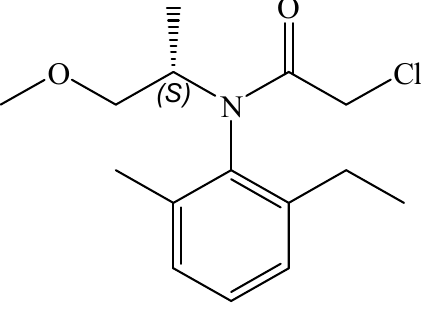
Figure 3. Commercial herbicide metolachlor (Dual Gold ® ).